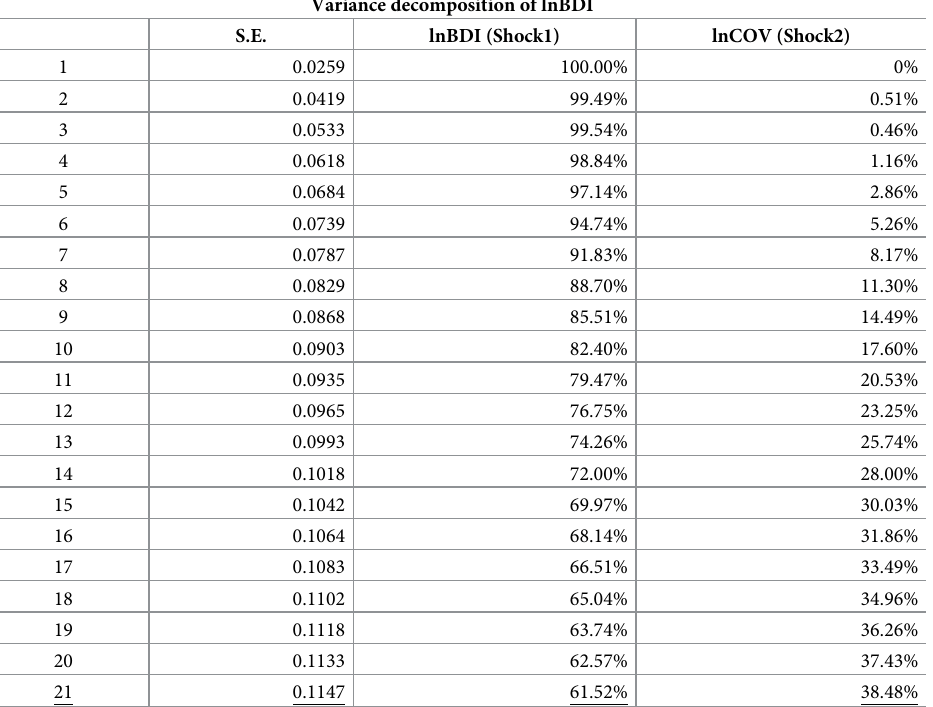
Table 7. Variance decomposition